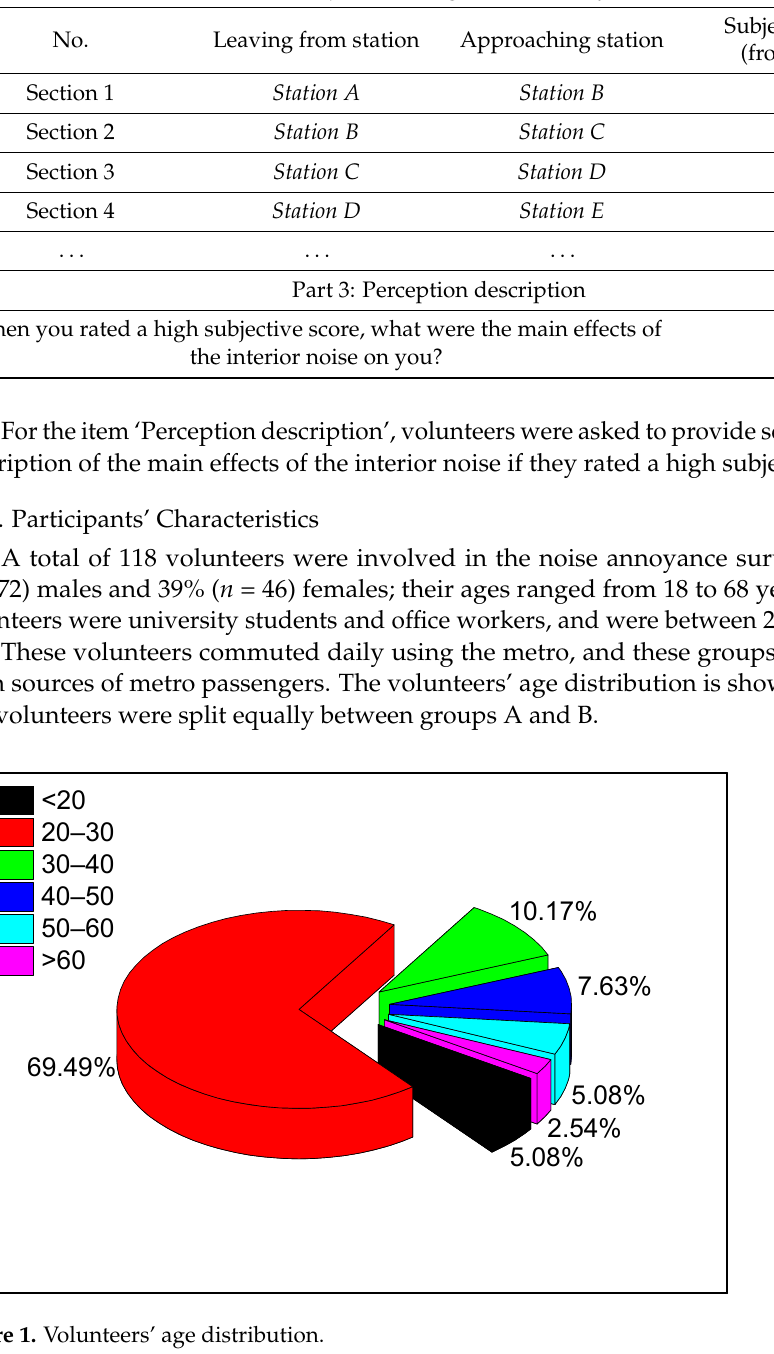
Figure 1. Volunteers’ age